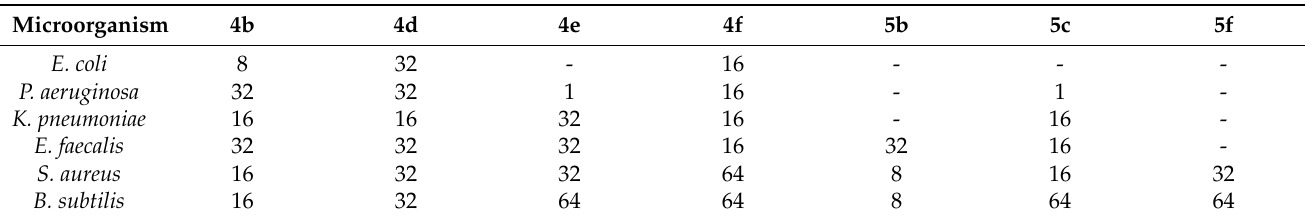
Table 8. The MBC to MIC ratios calculated for the compounds showing an antibacterial activity upon blue light